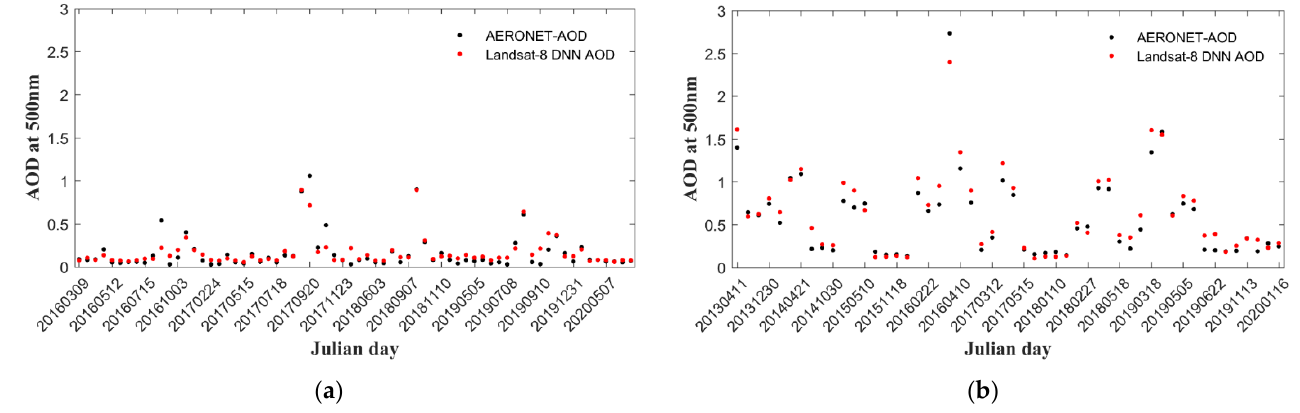
Figure 5. Example AOD time series at the Windpoort station ( a ) and the Chiang_Mai_Met_Sta station ( b ) from AERONET (in black) and Landsat-8 DNN AOD (in red).